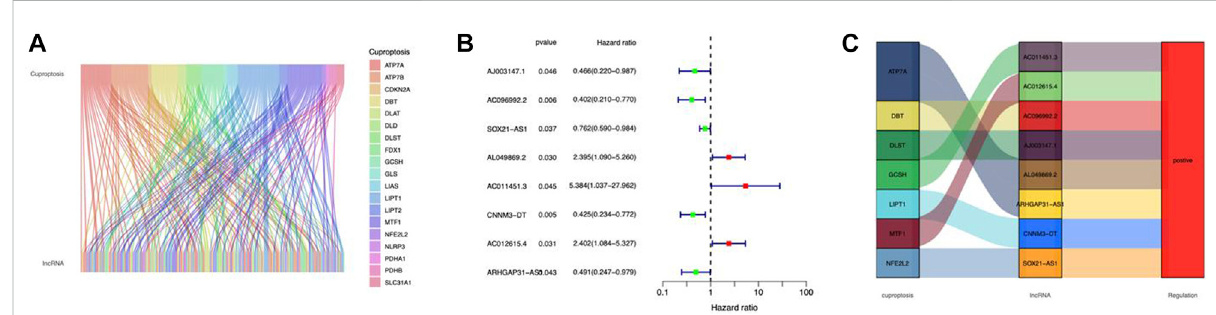
FIGURE 2 Identi fi cationofcuproptosis-relatedlncRNAsinCC. (A) Sankeyrelationshipdiagramofcuproptosisgenesandcuproptosis-relatedlncRNAs. (B) The cuproptosis-related prognostic lncRNAs extracted by univariate Coxregression analysis. (C) The regulatorybetweencuproptosis-related genes and lncRNAs.